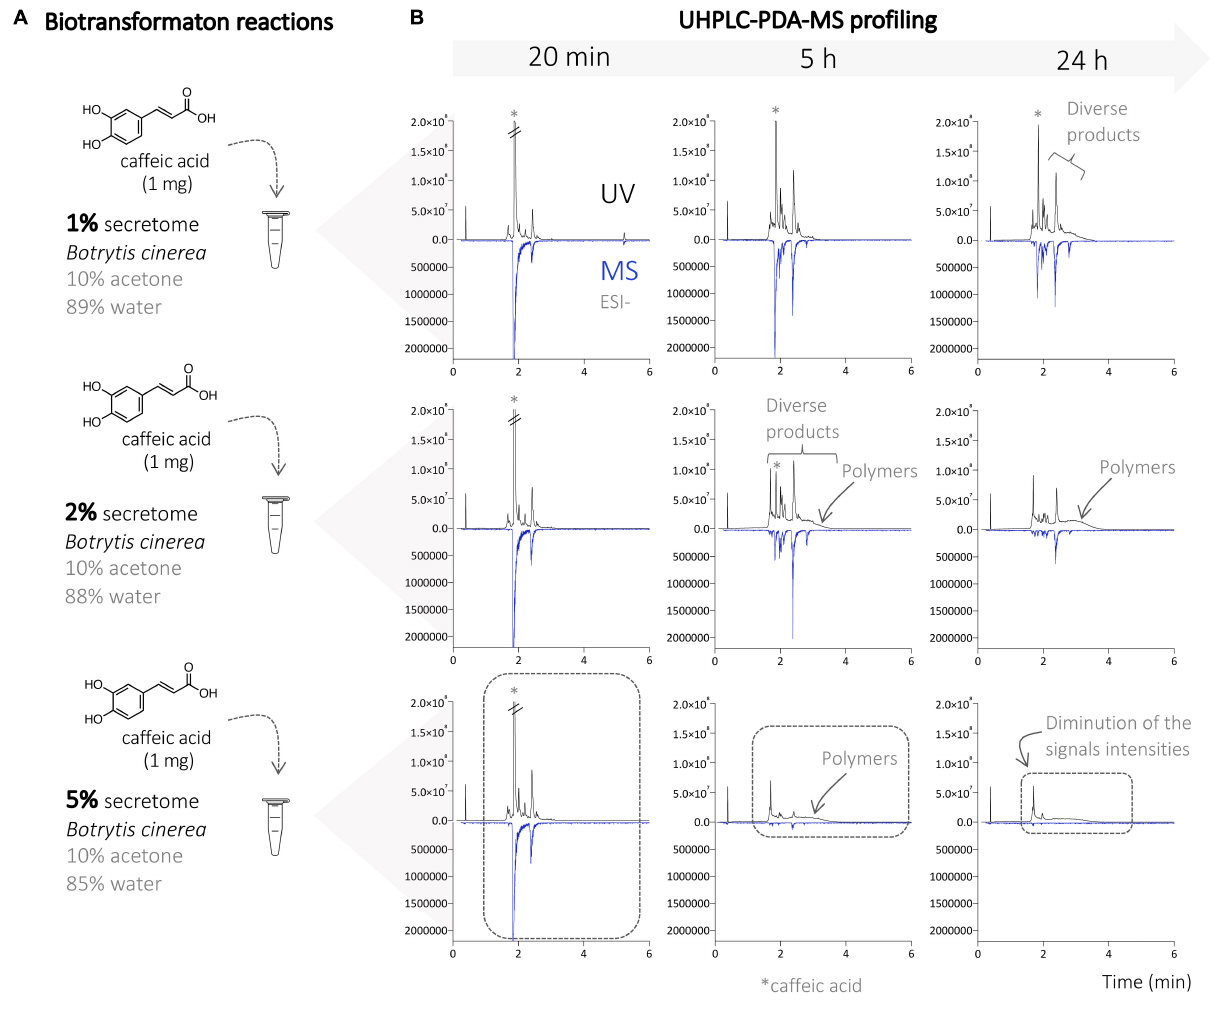
FIGURE 1 | (A) Biotransformation reactions of caffeic acid with different amounts of the enzymatic secretome of Botrytis cinerea (1, 2, and 5%). (B) UHPLC-PDA-MS profile of the different reactions on the analytical scale at different times (20 min, and 5 and 24 h). A strong decrease in signal intensity is observed with 5% secretome (at 5 and 24 h) due to the strong polymerization process leading to the generation of insoluble compounds (polymers). The chromatograms obtained at 10% corresponded to the ones obtained at 5% and are, therefore, not